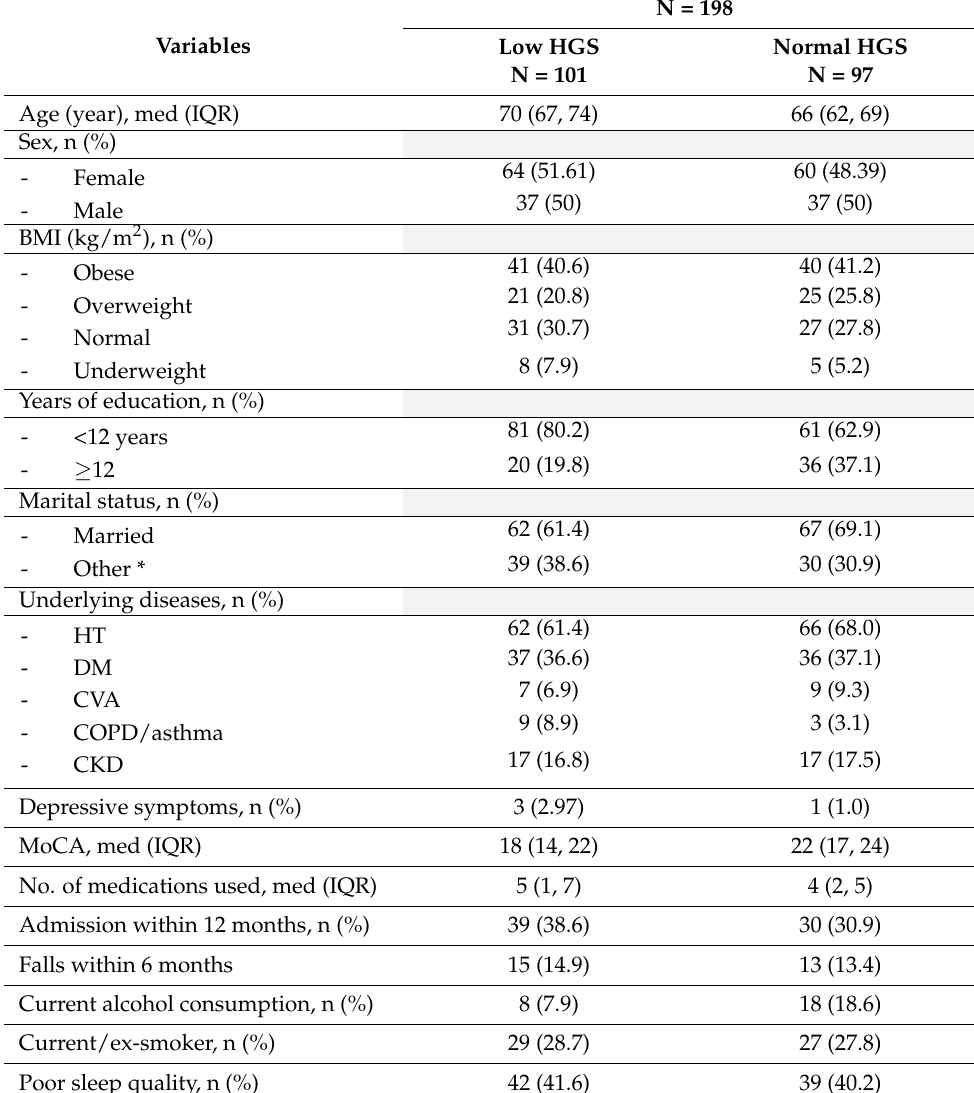
Table 1. Demographic data of the studied